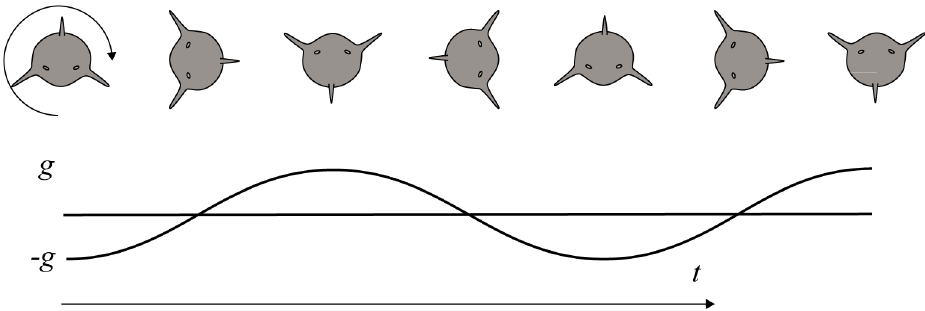
Fig 3. An example of a spinner dolphin rotating with a constant angular velocity about its own axis. The curve below shows the accelerometer signal from one axis of a three-axis accelerometer hypothetically placed at its center of rotation. With a 2 Π averaging window, the ODBA will amount to the average absolute value of the curve (6.24 m/s 2 ) despite there being no dynamic acceleration.